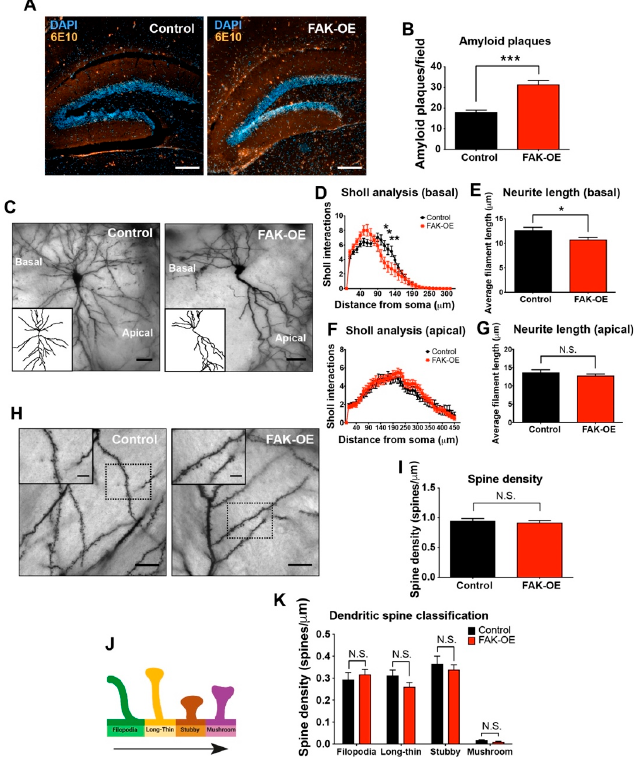
Figure 3. Hippocampal FAK overexpression increases amyloid plaque accumulation and reduces neuronal basal dendritic arborization. ( A ) Representative images of control and FAK-OE hippocampi labeled for amyloid plaques (orange, 6E10) and for cell nuclei (blue, DAPI). Scale bar, 200 μ m. ( B ) Quantification of amyloid plaque number in control and FAK-OE hippocampi. *** p < 0.001 by an unpaired Student’s t -test. N = 10 fields per group. ( C ) Representative images of CA1 hippocampus pyramidal neurons from control and FAK-OE mice. ( D ) Sholl interaction analysis of basal dendritic intersections of control and FAK-OE pyramidal neurons. * p < 0.05, ** p < 0.01 by two-way ANOVA with the Bonferroni post hoc test. ( E ) Average dendritic filament length of basal regions of control and FAK-OE pyramidal neurons. p = 0.0374 by an unpaired Student’s t -test. ( F ) Sholl interaction analysis of apical dendritic intersections of control and FAK-OE pyramidal neurons. p = N.S. by two-way ANOVA with the Bonferroni post hoc test. ( G ) Average dendritic filament length of apical regions of control and FAK-OE pyramidal neurons. p = N.S. by an unpaired Student’s t -test. N = 45 neurons from five mice in each group. ( H ) Representative images of dendrites with spines of hippocampal pyramidal neurons of control and FAK-OE mice. Scale bar, 5 μ m. ( I ) Quantification of number of spines (spine density) in arbors from control and FAK-OE pyramidal neurons. p = N.S. by an unpaired Student’s t -test. ( K ) Quantification of spine types (filopodia, long thin, stubby, and mushroom); ( J ) in control and FAK-OE neurons. p = N.S. by an unpaired Student’s t -test between control and FAK-OE in each type. N = 30 neurons from five mice in each group.